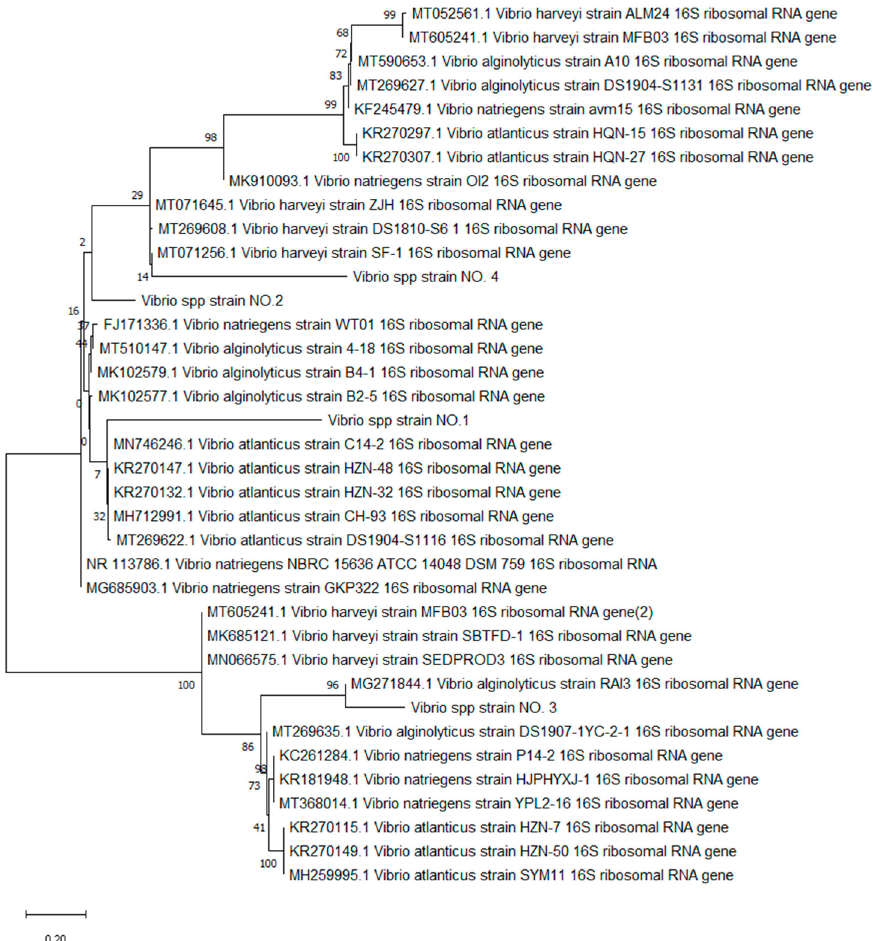
Figure 4. Phylogenetic tree of the four Vibrio strains isolated from diseased shrimp, Litopenaeus vannamei was constructed using maximum likelihood based on the 16S rRNA sequences of Vibrio spp. The numbers above the branches are the values calculated through a bootstrap analysis (1000 replicates).